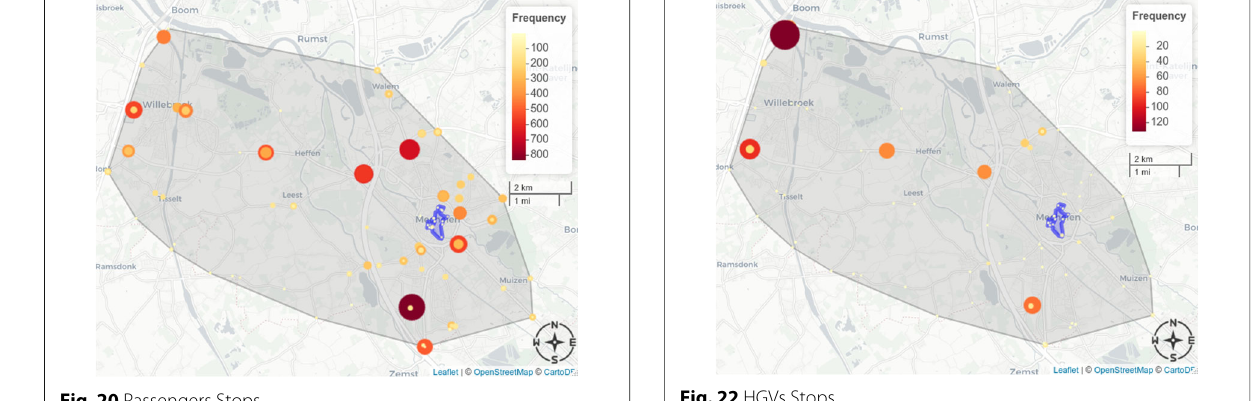
Fig. 20 Passengers Stops Fig. 22 HGVs